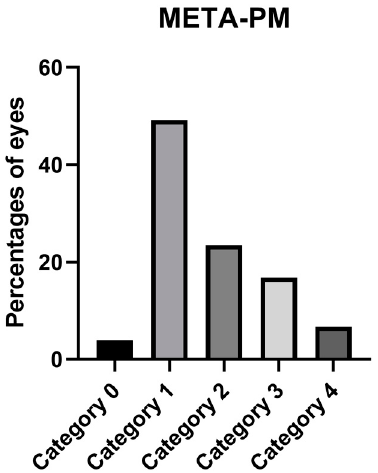
Figure 3. Percentage of eyes in the categories of the META-PM classification. The number of eyes in each category of the ATN classification is shown in Table 1. Table 1. Number of Eyes in Each ATN Category. Atrophic No. of Eyes Classification